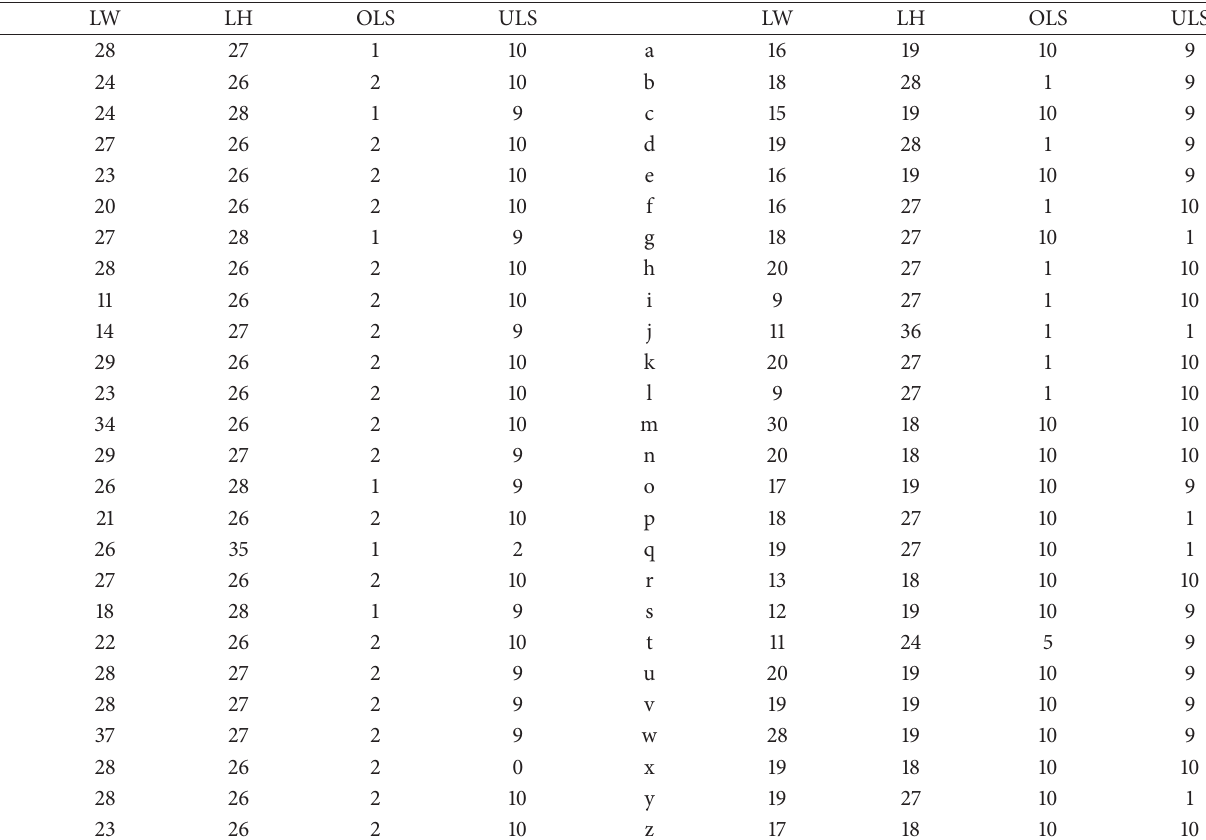
Table 2: The feature information of letters with New Times Roman and 20 fonts in database.